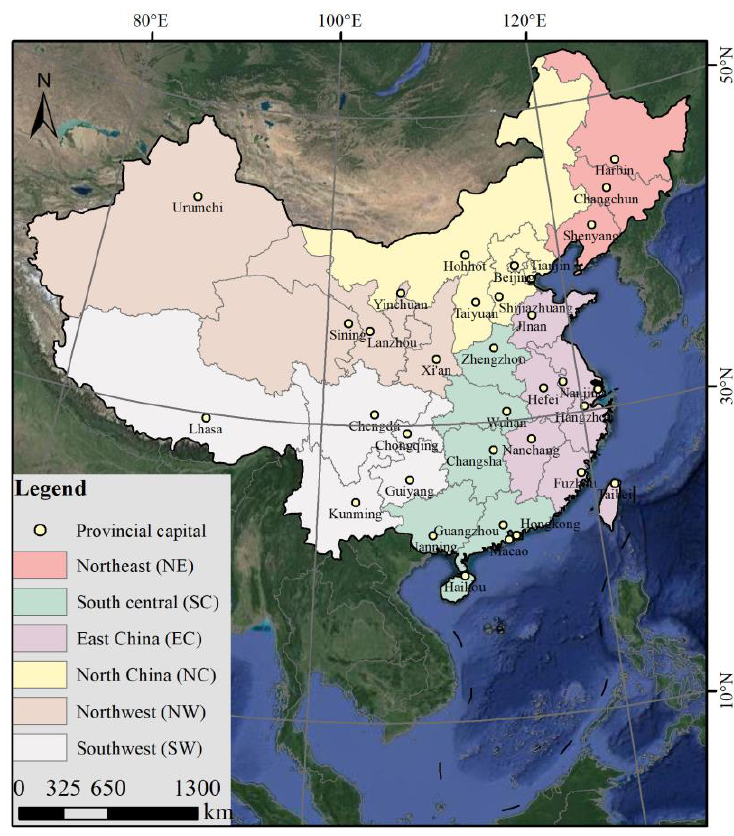
Figure 1. Sketch of study area.